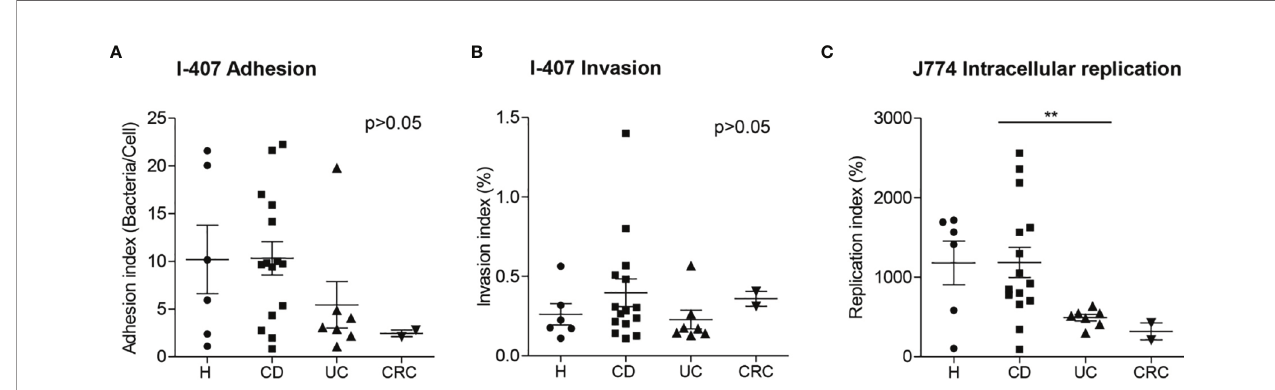
FIGURE 3 | Adhesion (A) , invasion (B) and replication indices (C) of AIEC and AIEC-like clones isolated from patients with different intestinal diseases and control subjects. Data from Crohn ’ s disease (CD) patients and healthy controls (H) has been extracted from a previous study (2). Only clonally independent strains are represented. A representative isolate has been chosen in cases that more than one isolate corresponded to the same clone. UC, ulcerative colitis; CRC, colorectal cancer. **p ≤ 0.01